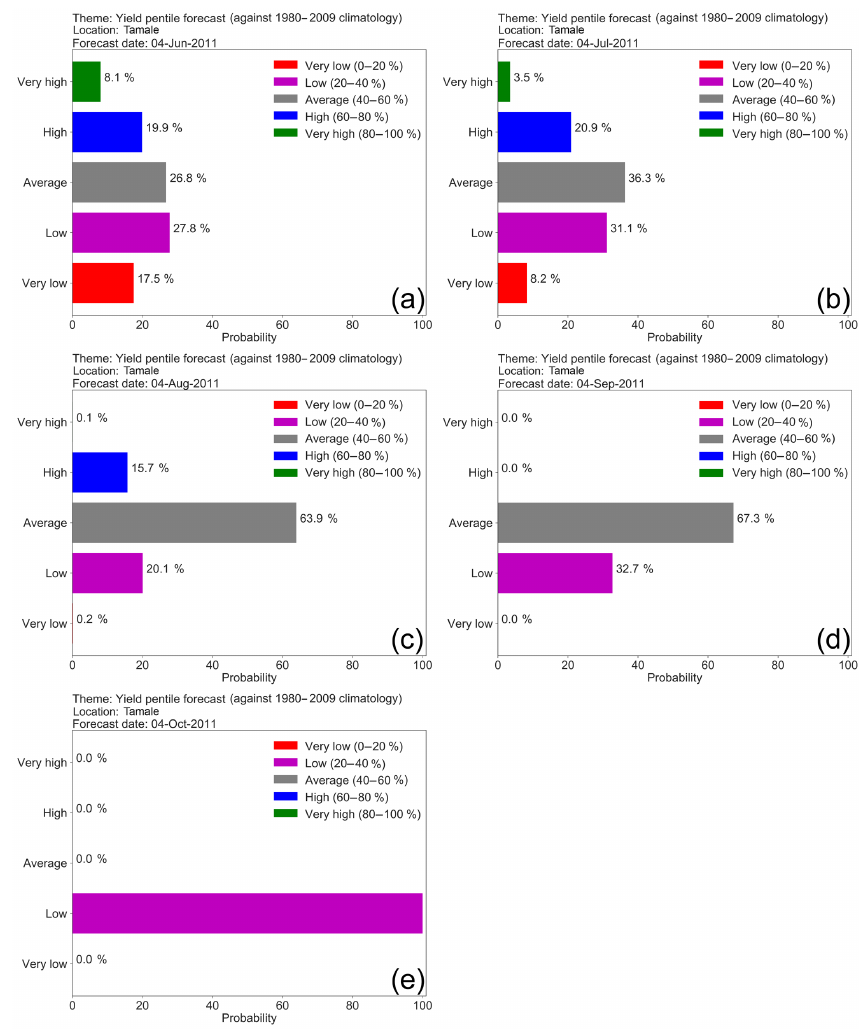
Figure 12. Yield probability forecast for the year 2011 for five forecast dates, (a) 4 June, (b) 4 July, (c) 4 August, (d) 4 September and (e) 4 October, when ensembles are weighted by a perfect tercile seasonal rainfall